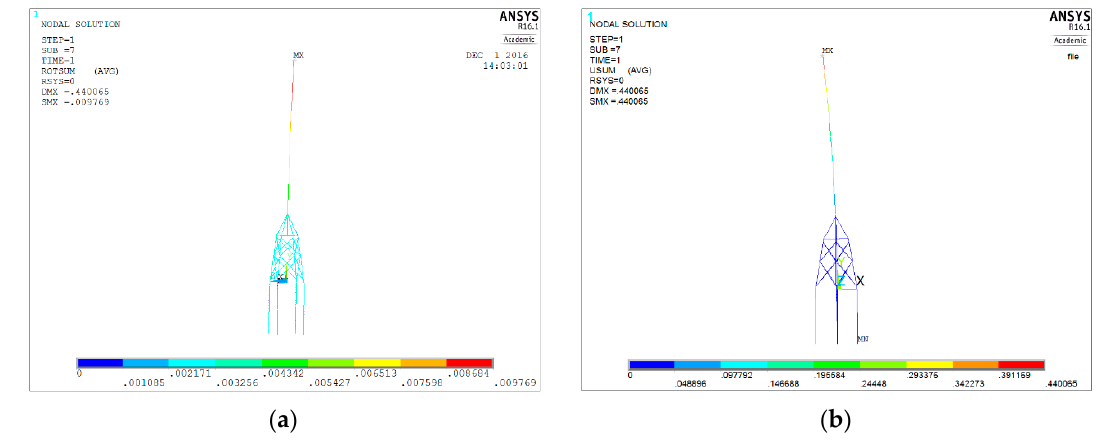
Figure 6. Deformation of the support structure: ( a ) total rotation vector; ( b ) total displacement vector.